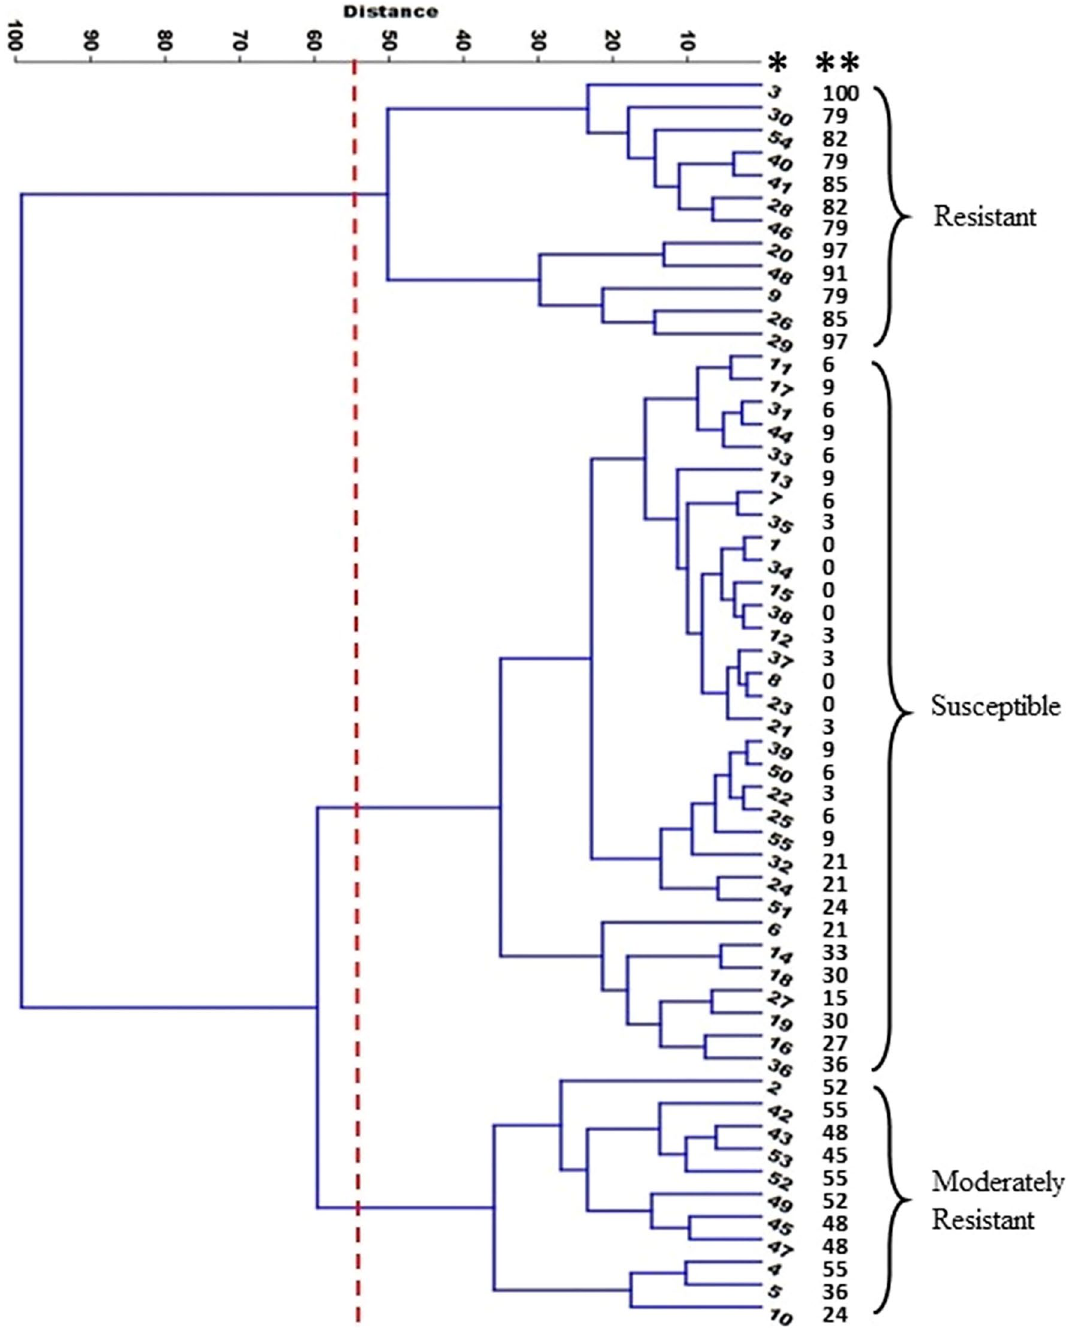
Figure 1. Cluster analysis of 55 wheat differential responses against 33 leaf rust isolates showing that wheat genotypes can be categorized into three major clusters including resistant, susceptible and moderately resistant groups. * genotype number, ** Percentage of avirulent